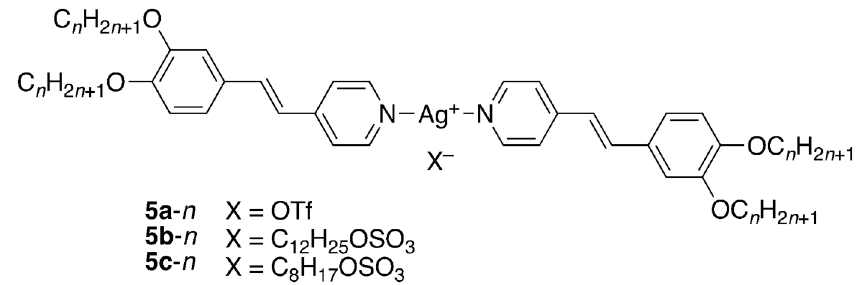
Figure 11. Structure of the silver complexes 5 - n .